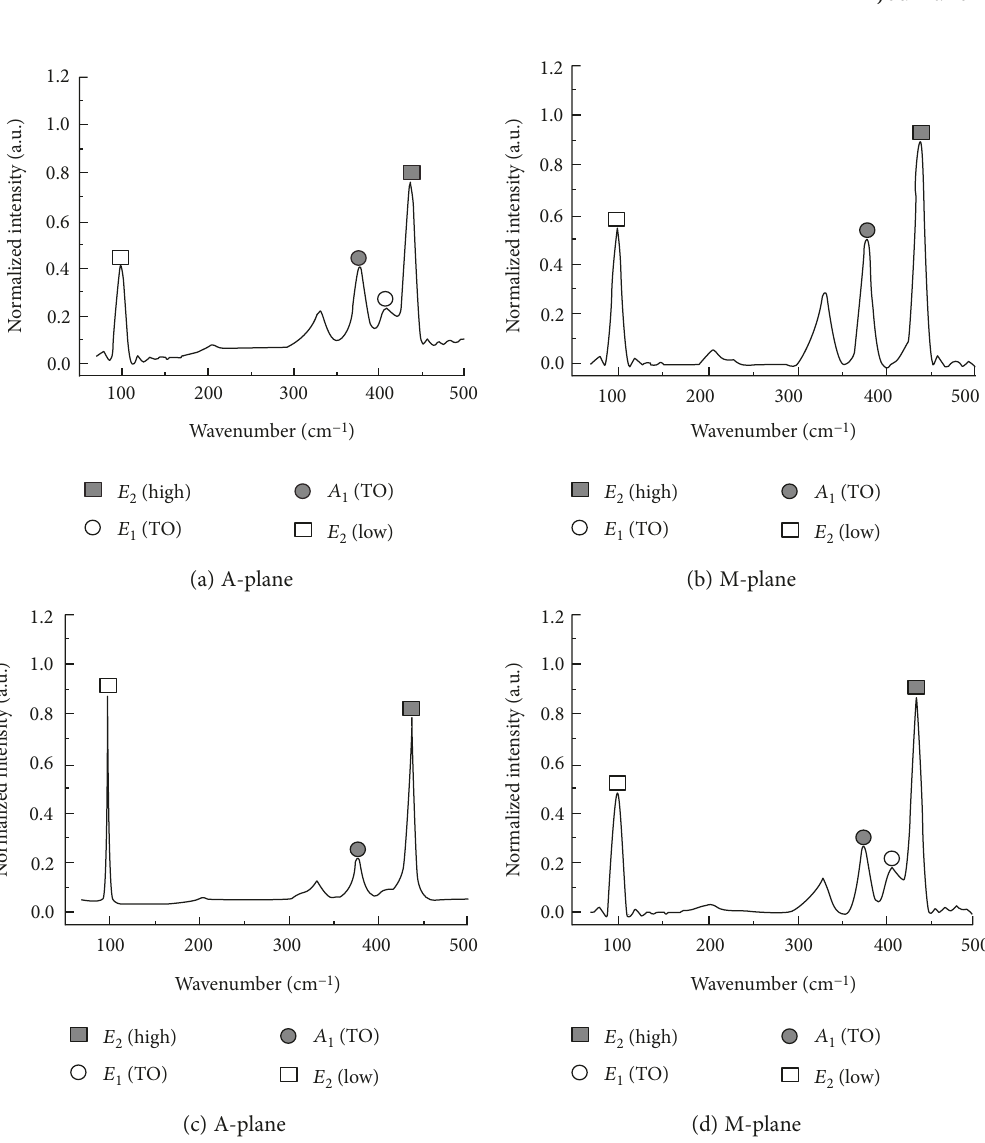
Figure 2: Polarized Raman spectra collected on A- and M-plane ZnO samples in parallel (a and b) and cross (c and d) polarization con fi